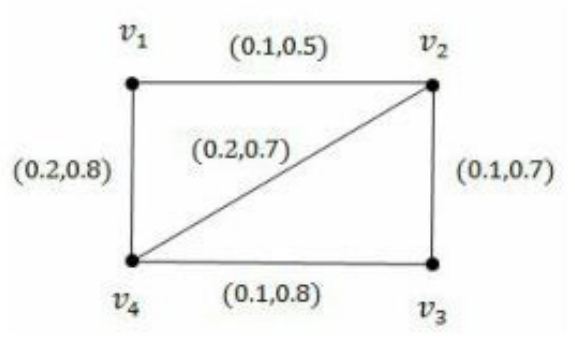
Figure 14. VG ( G 2 ).